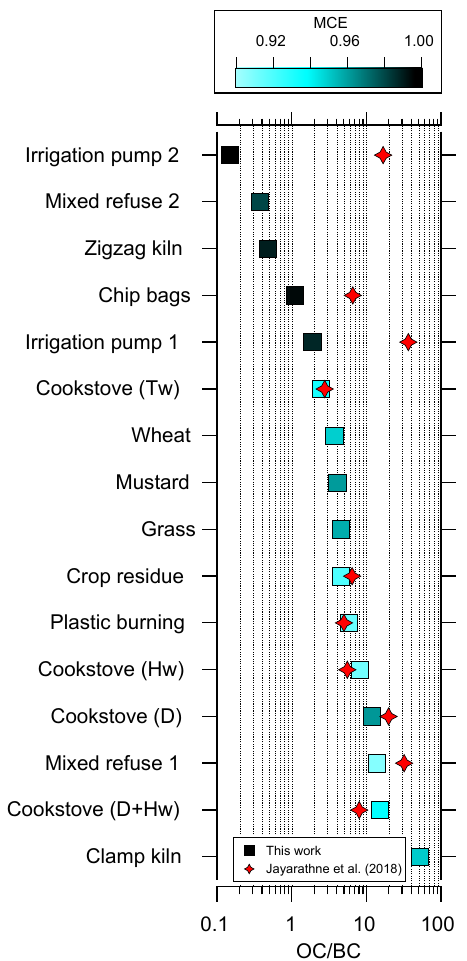
Figure 6. The organic carbon (OC) to black carbon ratio (g / g) of the investigated emission sources from this work and Jayarathne et al. (2018). The markers are colored by average MCE values from Stockwell et al. (2016); light blue indicates MCE of ∼ 0 . 90 and black indicates an MCE close to 1. Cookstove fuel designated as D for dung burning, Hw for hardwood burning, and Tw for stick and twig